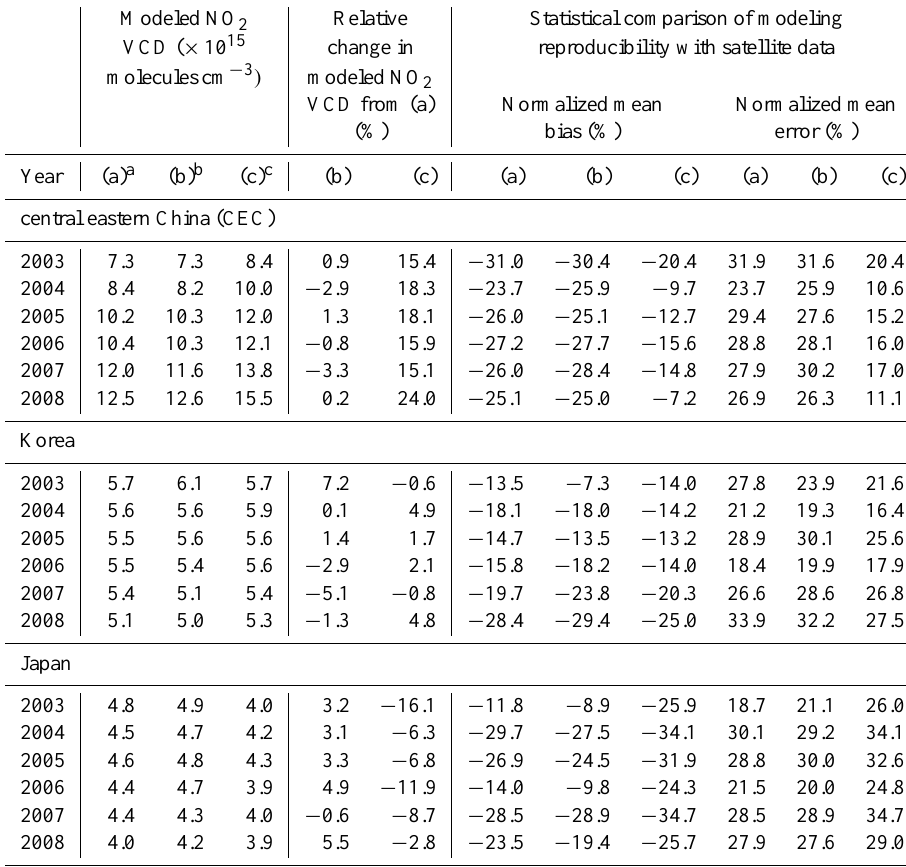
Table 2. Modeling reproducibility of annual mean NO 2 VCD compared to SCIAMACHY data. Modeled NO